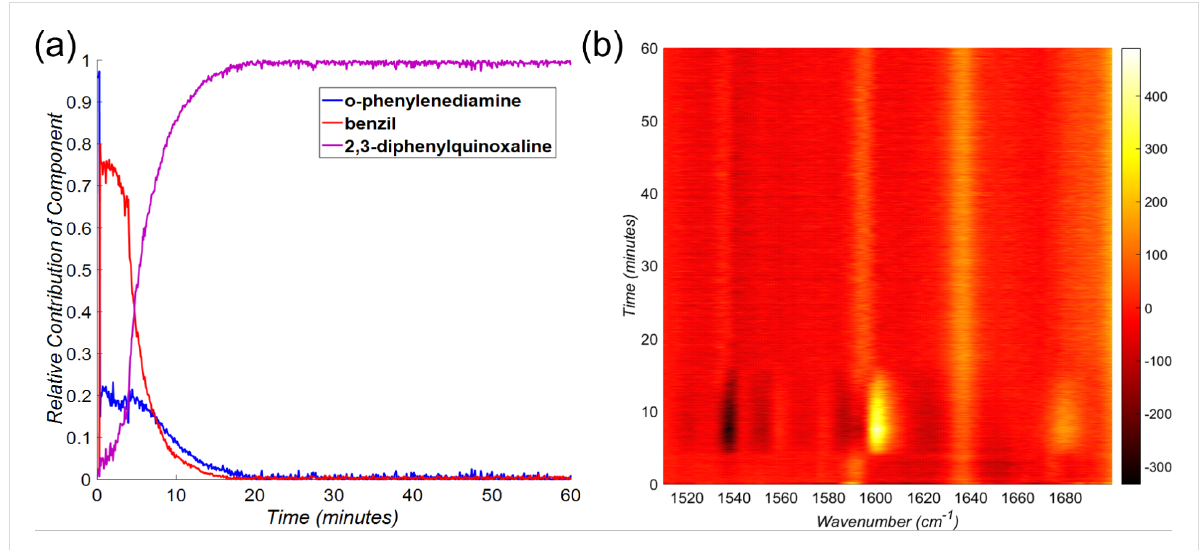
Figure 3: (Left) Estimated contribution of each component for each Raman spectrum over time of the synthesis of 2,3-diphenylquinoxaline at 30 Hz. (Right) Residual plot of the difference between experimental and estimated Raman spectra. In this case, this plot suggests an overestimation of 2,3-diphenylquinoxaline and an underestimation of o -phenylenediamine between ≈ 5 and ≈ 15 minutes. More information on the fitting can be found in Supporting Information File